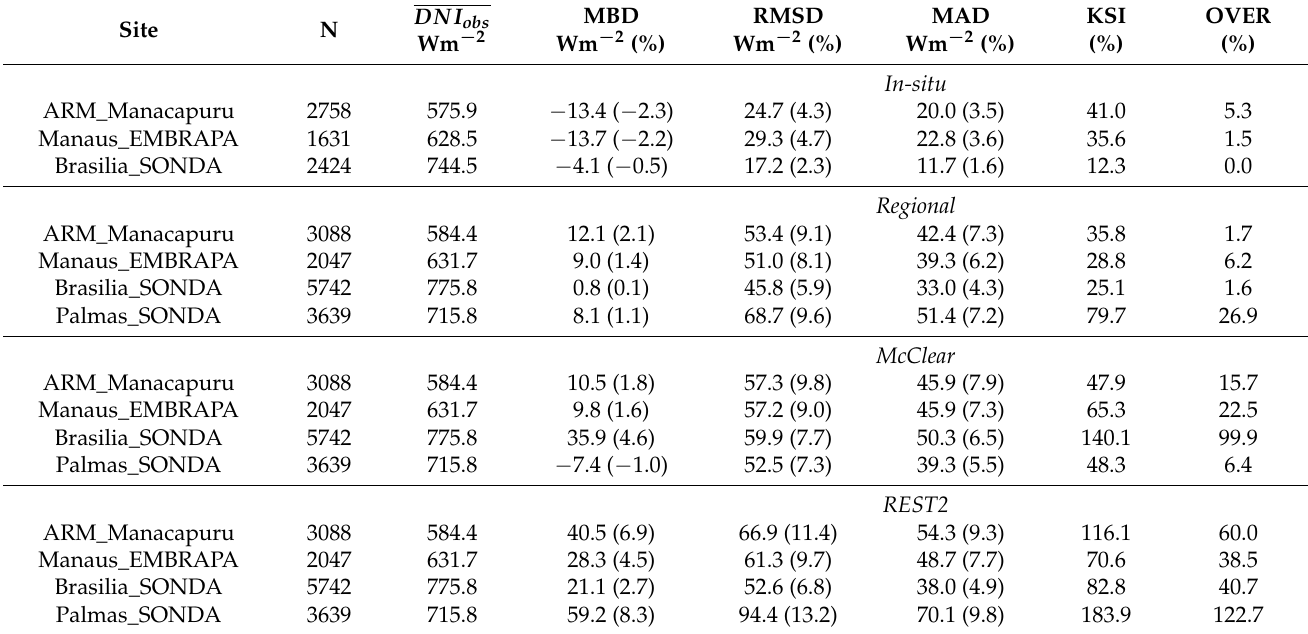
Figure 9. Scatter plot for DNI observational data versus BRASIL-SR outputs obtained without δ -Eddington scaling for the four ground measurement sites. Table 5. Benchmark comparisons between clear-sky DNI observations and estimations with BRASIL-SR (experiments in-situ and regional , not using δ -Eddington scale), McClear and